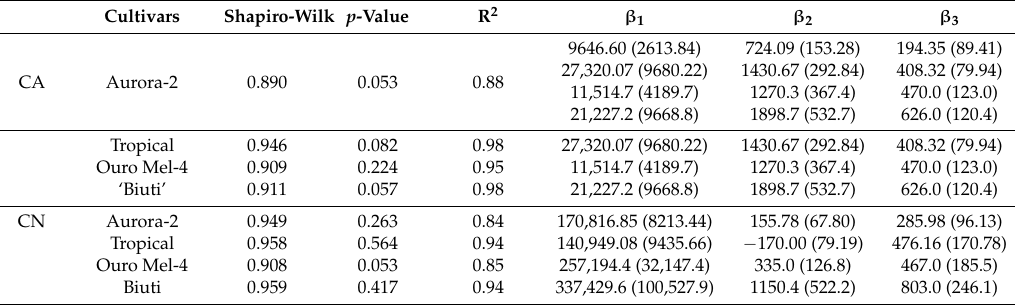
Table 3. Shapiro–Wilk estimation of the residues, p -value, parameter estimates ( β 1, β 2 and β 3), standard deviation (in parenthesis) and coefficient of determination (R 2 ), according to the logistic model studied for the cell area (CA) and cell number (CN) of four peach